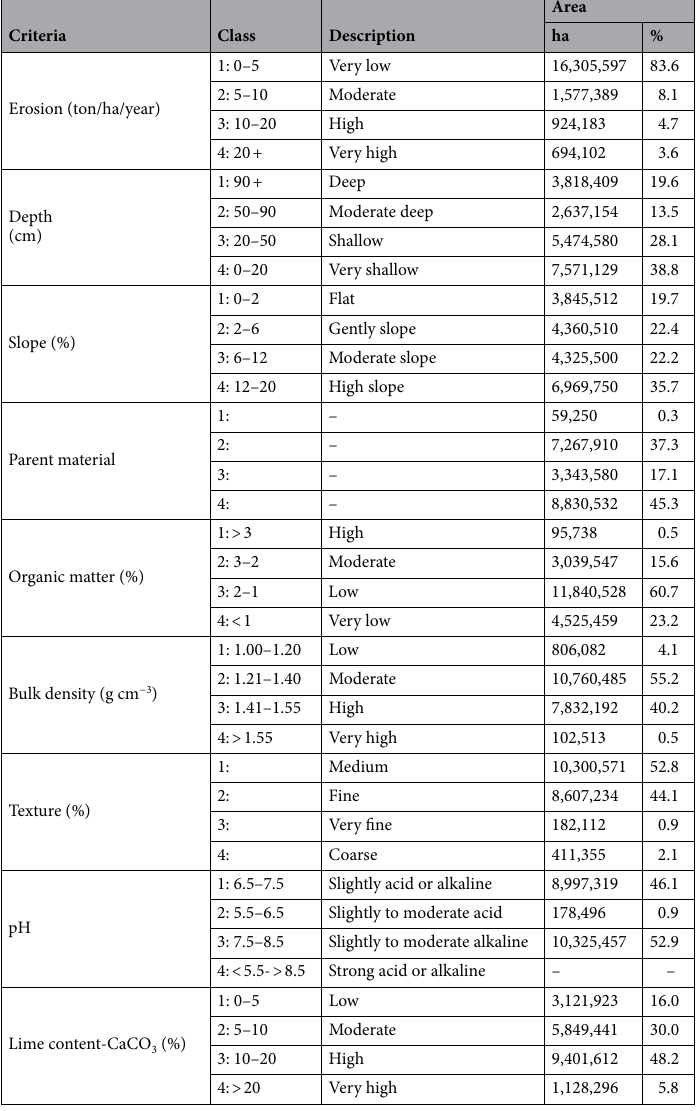
Table 9. Spatial and proportional distribution of some criteria for land suitability for agriculture usages in Central Anatolia